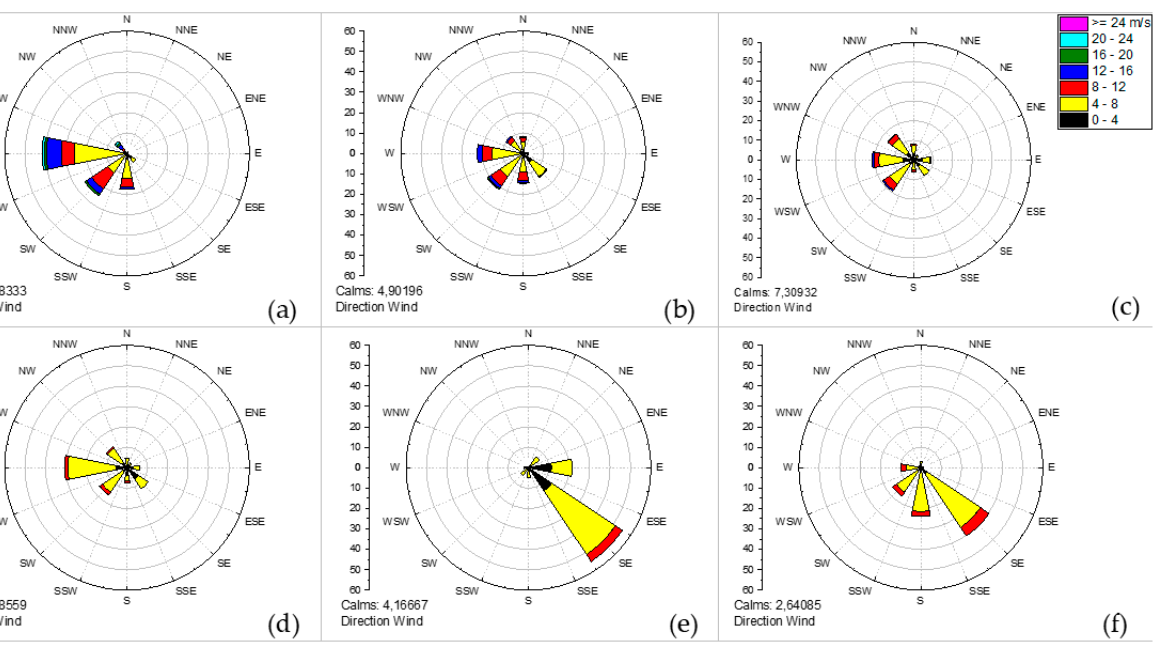
Figure 5. Wind roses for the study period: ( a ) 25 11 1999–06 12 1999; ( b ) 07 12 1999–26 01 2000; ( c ) 27 01 2000–23 05